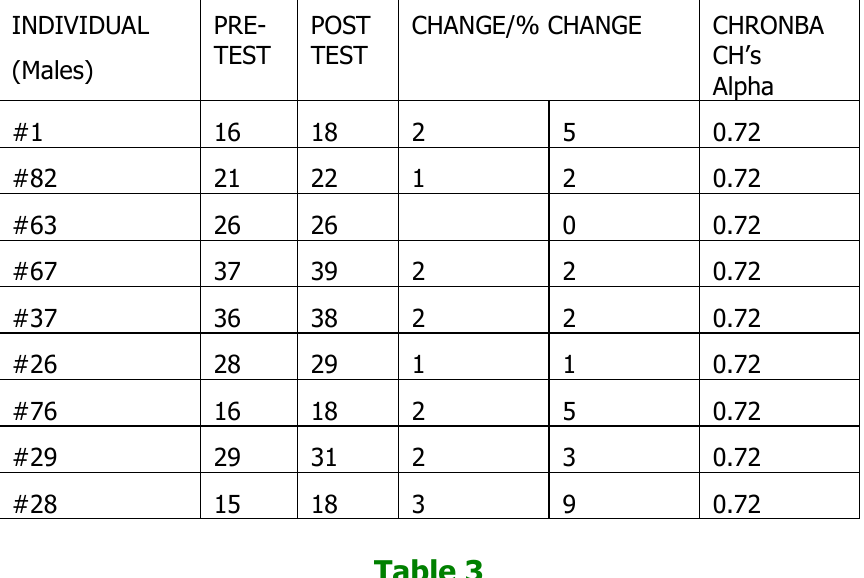
Results of Self-Esteem (Pre-test/post-test scores) of Females in the